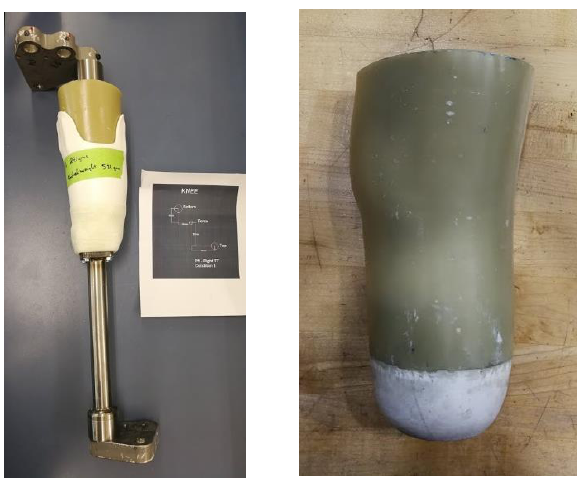
Figure 2 (Left). Componentry Attached to 3D-Printed Socket. Figure 3 (Right). High-Density Urethane Residual Limb